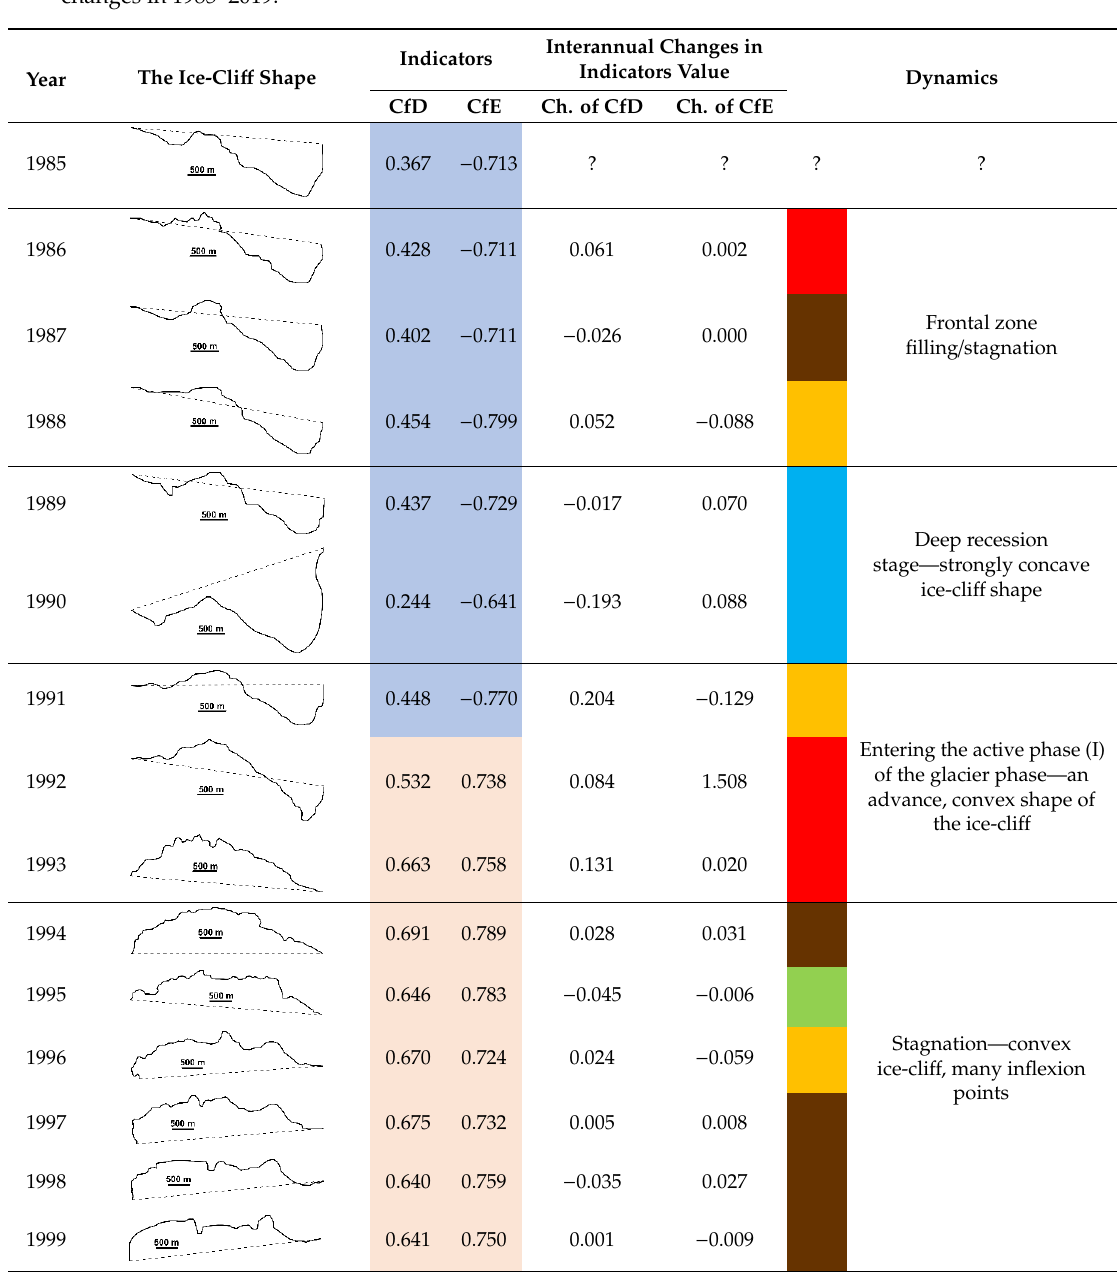
Table4. CharacteristicsofMonacobreendynamicsbasedon CfD and CfE indicatorsandtheirinterannual changes in 1985–2019.